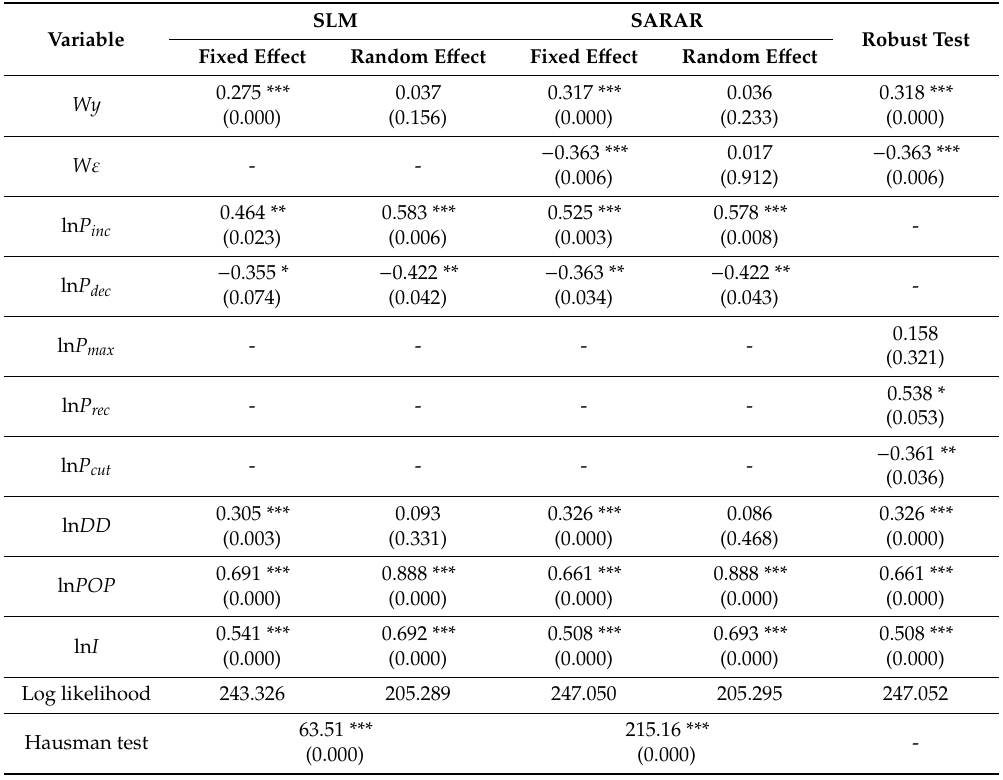
Table 4. Estimation results of SLM and SARAR model and robust